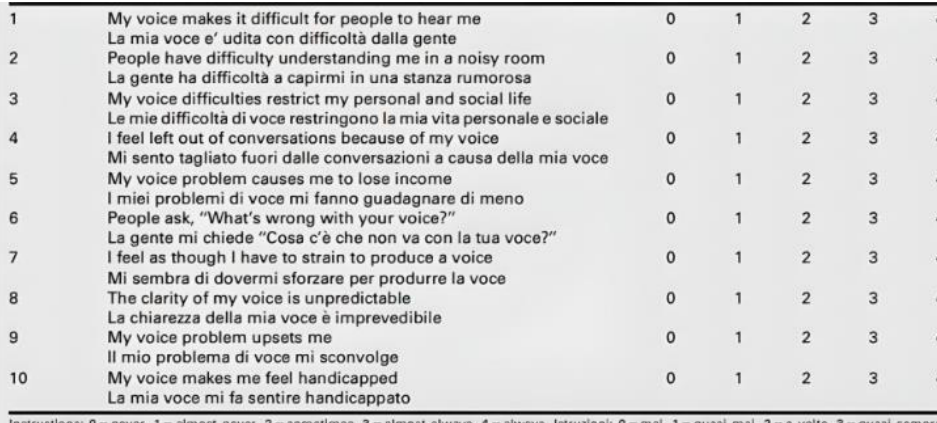
Figure 1. Italian VHI-10 Questionnaire [25].